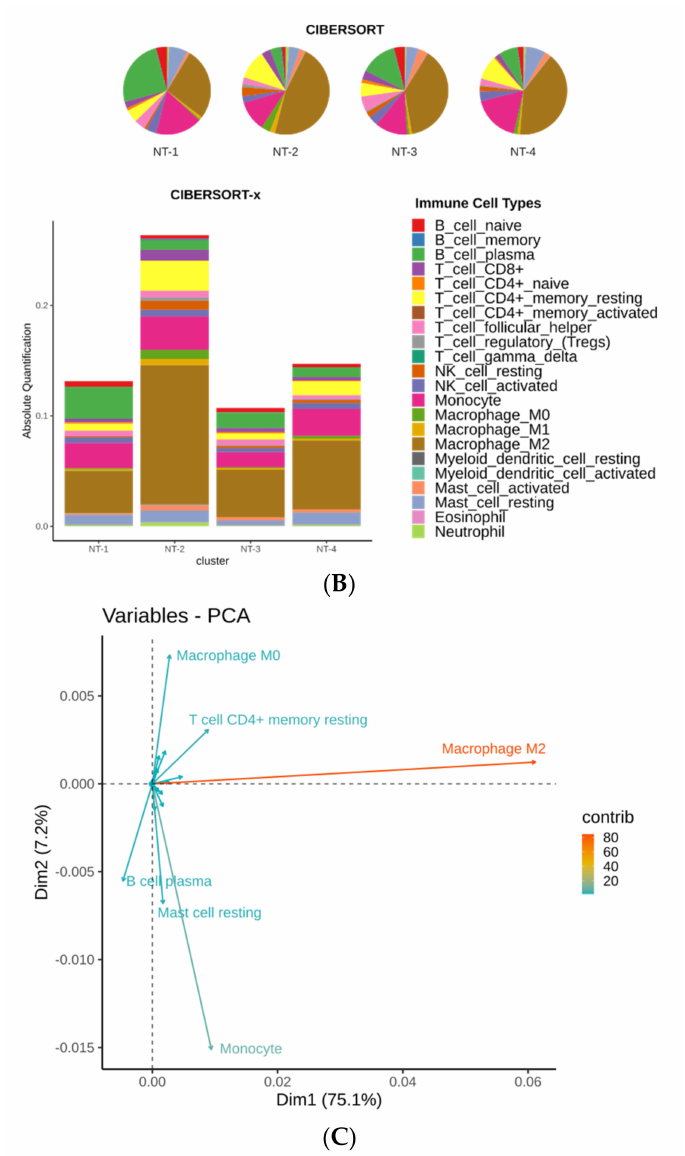
Figure 7. ( A ) ESTIMATE R tumor purity for the NT-1, NT-2, NT-3 and NT-4 gliomas. Purity scores were inferred from the presence of infiltrating immune/stromal cells (*** p < 0.001). ( B ) Immune cell type inference for NT-1, NT-2, NT-3 and NT-4 gliomas using CIBERSORT and CIBERSORT-ABS tools. CIBERSORT generates an immune cell fraction relative to the total immune cell content; CIBERSORTx generates an absolute proportion of each cell type. ( C ) Variable contributions within the first and second principal components. The PCA was performed on the CIBERSORTx immune cell composition inference